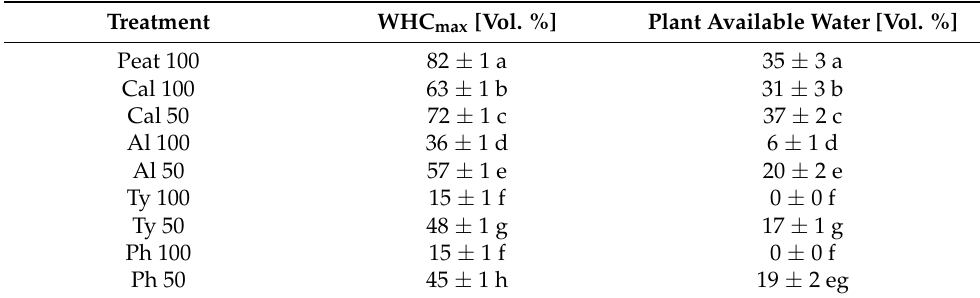
Table 4. Maximum water-holding capacity (WHC max ) and plant available water between − 10 and − 100 hPa of treatments in stage 1. WHC max n = 4 and plant available water n = 16, variance analysis: Kruskal–Wallis, post hoc test: pairwise t test, p < 0.05. Different letters indicate significant